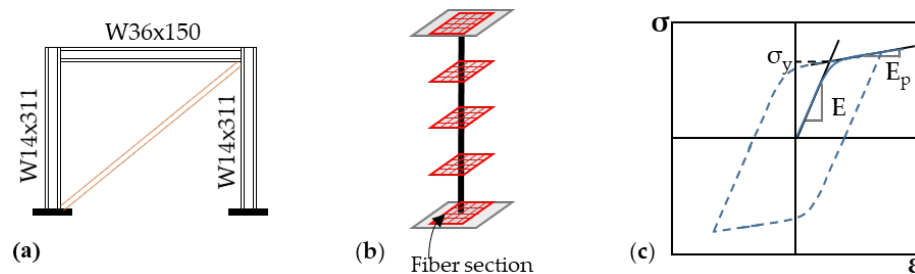
Figure 4. Schematic representation of: ( a ) CBF model, ( b ) nonlinear elements with distributed plasticity, and ( c ) stress – strain relationship of Steel 02 model. Mach. Learn. Knowl. Extr. 2020 , 2 FOR PEER REVIEW